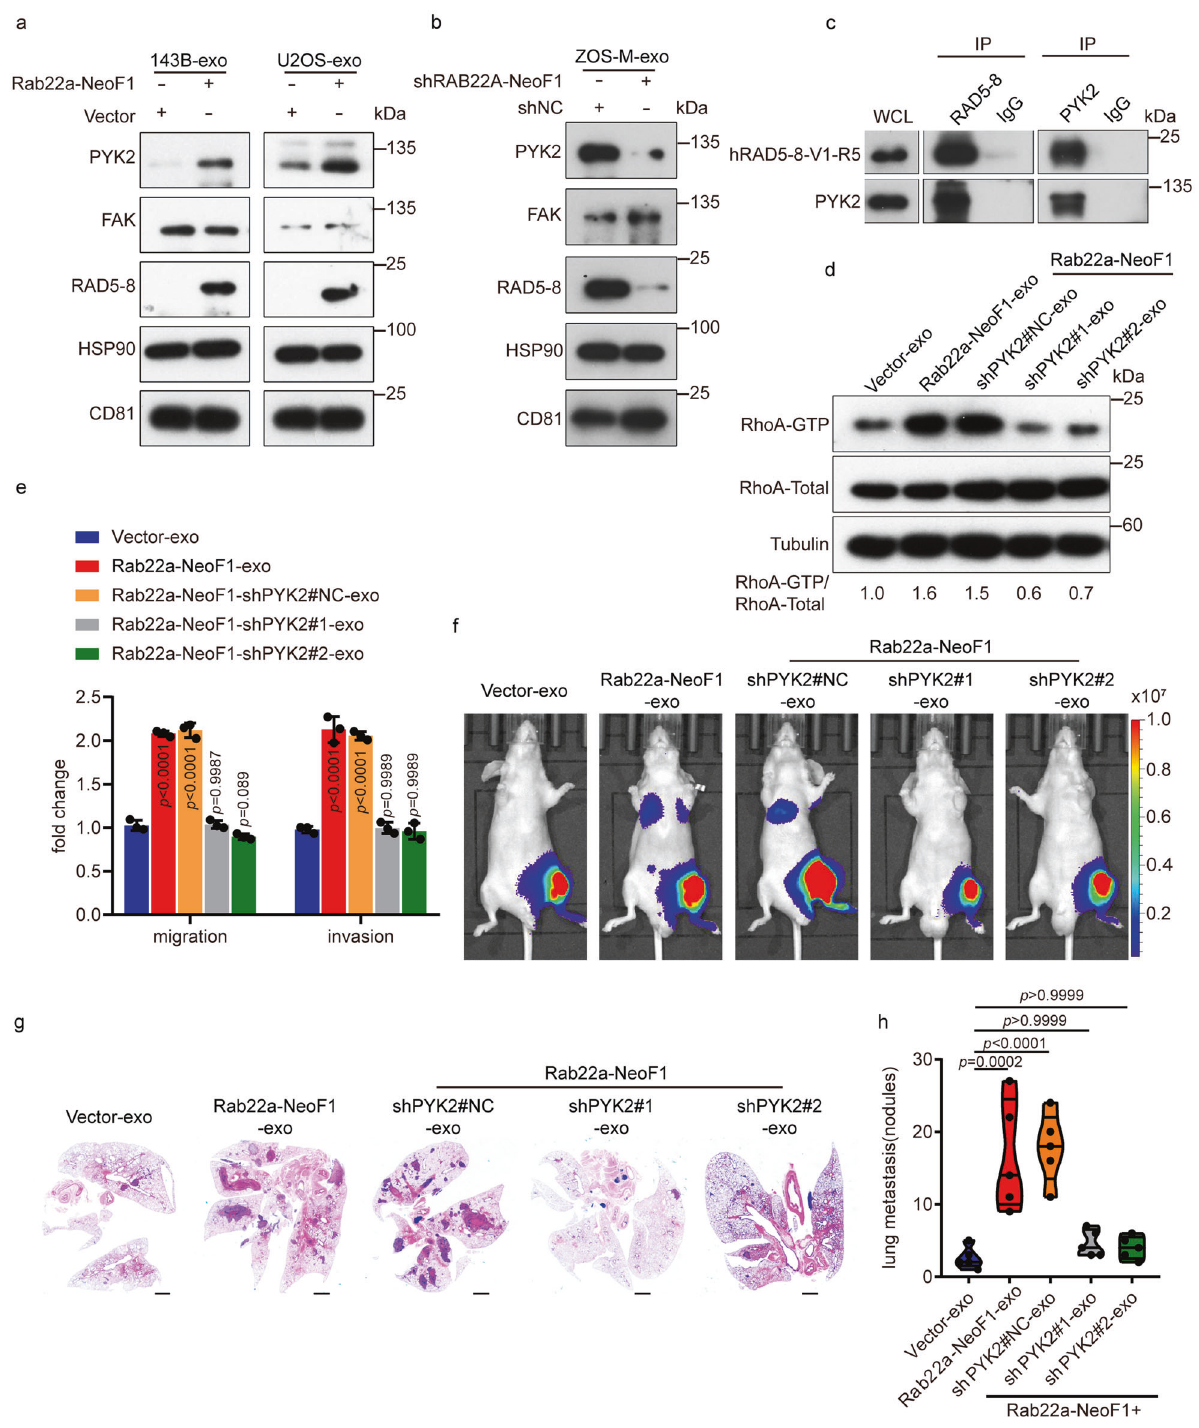
Fig. 4 The functions of exosomes containing Rab22a-NeoF1 fusion protein on its negative recipient cancer cells requires its binding partner PYK2 from donor cells. a , b The exosomes derived from the indicated stable 143B and U2OS ( a ), as well as ZOS-M ( b ) cells were puri fi ed and subjected to Western blotting. c The co-IPs were performed using ZOS-M cells with anti-mAb RAD5 – 8, anti-PYK2, or anti-IgG at their endogenous levels. WCL whole-cell lysate of ZOS-M cells. d The 143B cells were treated with the indicated exosomes for 1 h and then were lysed. Rho-GTP forms were pulldown by RBD beads and were subjected to Western blotting. The relative intensity of RhoA-GTP was quanti fi ed with the ImageJ software and normalized with RhoA-Total. Data in a – d are representative of n = 3 biologically independent experiments. e The 143B cells were treated with the indicated exosomes for 24 h and then were subjected to migration and invasion assays. Data are mean ± s.d. of n = 3 biologically independent experiments. P values are shown. f – h Representative IVIS imaging ( f ), H&E-stained lung sections ( g ), and quanti fi cation of lung metastatic foci ( h ) from mice orthotopically injected 143B-Luc cells with the indicated exosomes. n = 5 biologically independent mice. Data are mean ± s.d. P values are shown. Scale bar, 2 mm